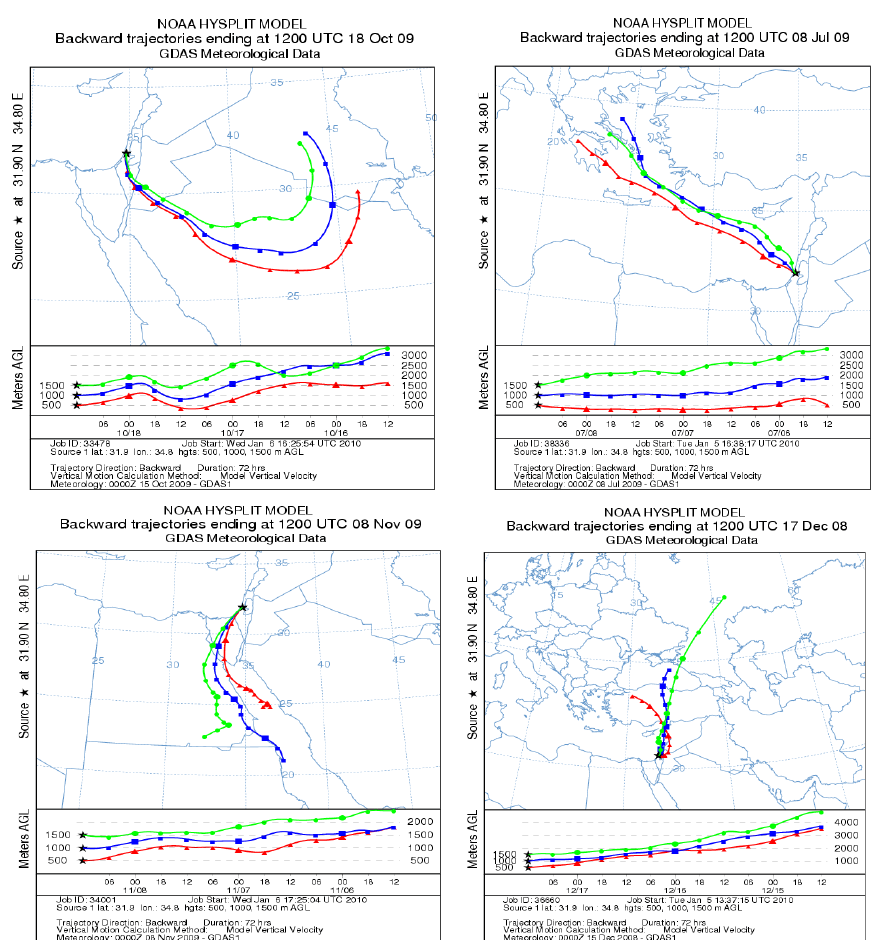
Fig. 8. Typical trajectories found for each sample with clockwise direction: Arabian peninsula, southern Europe & Mediterranean Sea, North Africa & Sahara and Turkey & Central Western Asia. In most cases the trajectories obtained in the different heights were similar to each other. In cases at which trajectories at the different heights deviated from each other, the trajectory plotted at the average height of 1000m was used to classify the sample to the sectors shown in Fig.